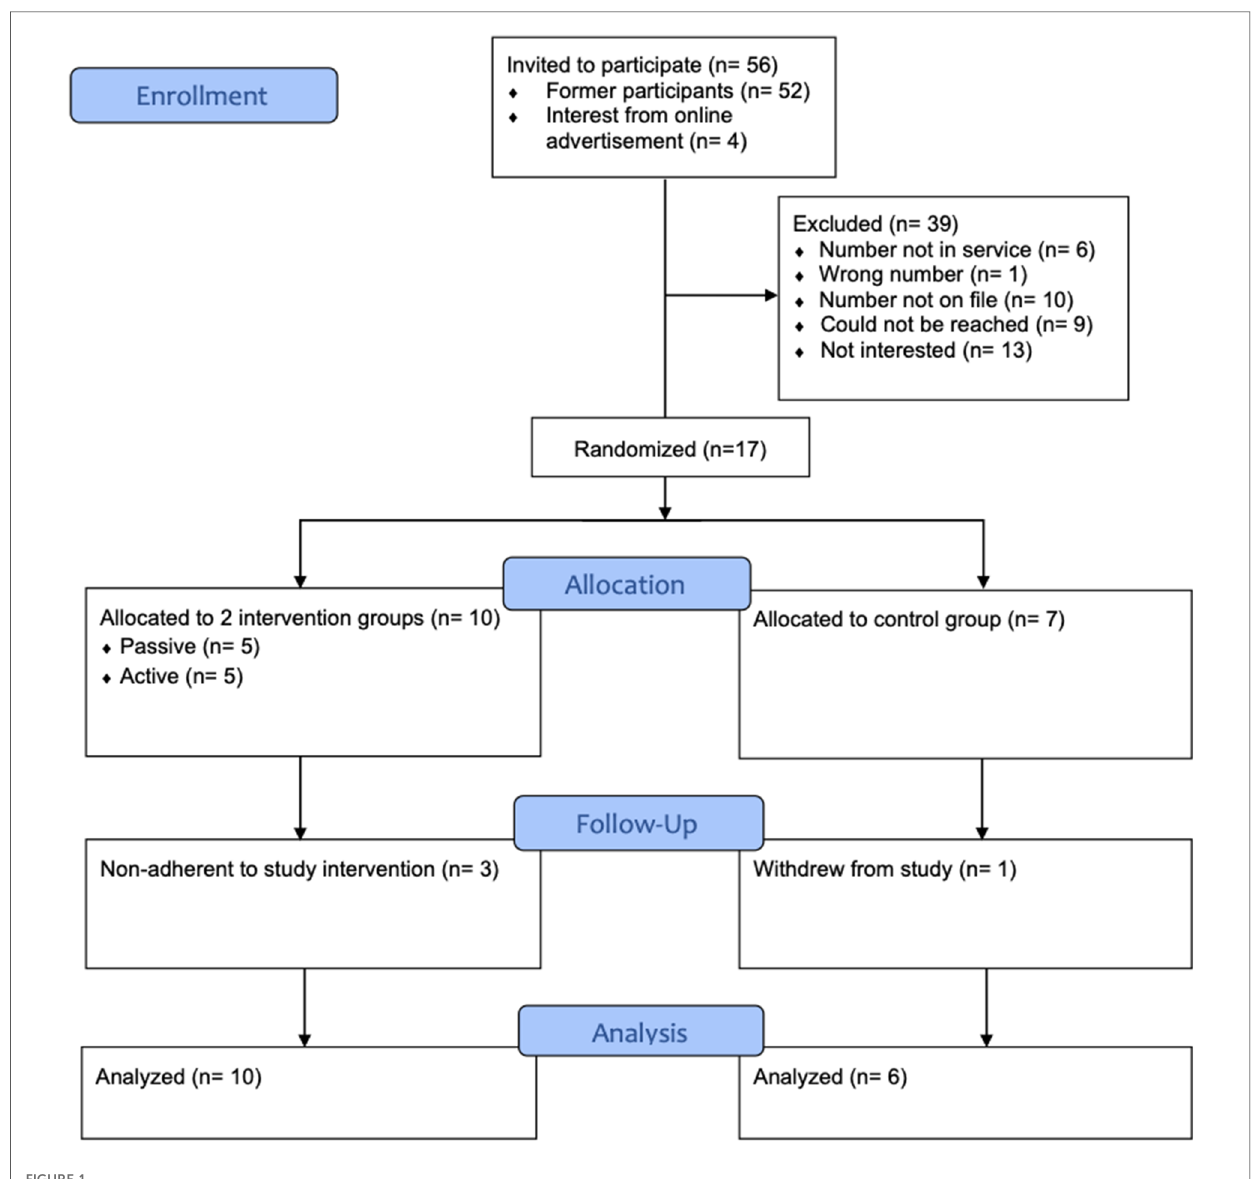
FIGURE 1 Flow diagram of participant recruitment.